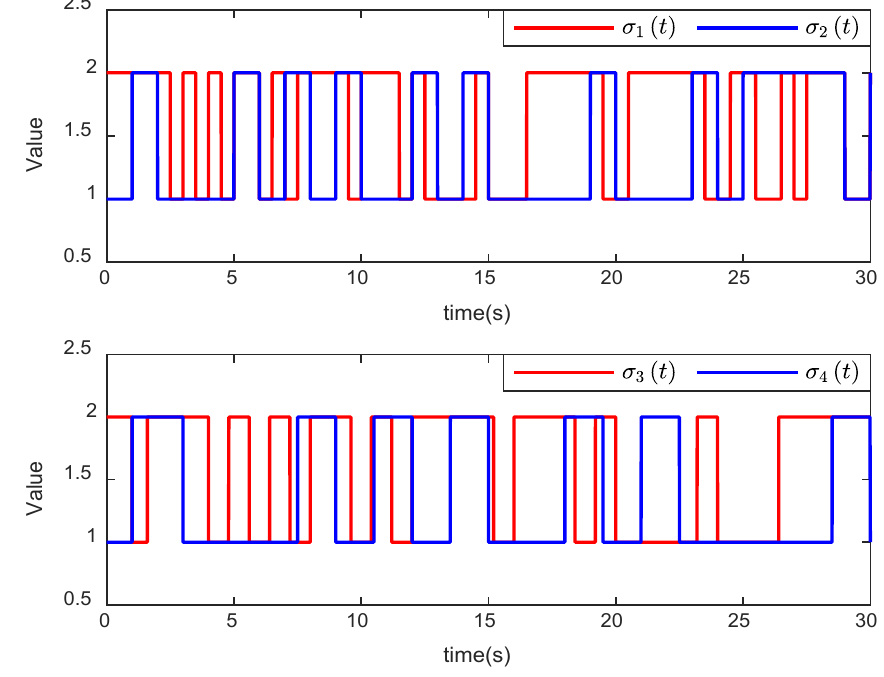
Figure 12. The switching signals σ i ( t ) of nonlinear